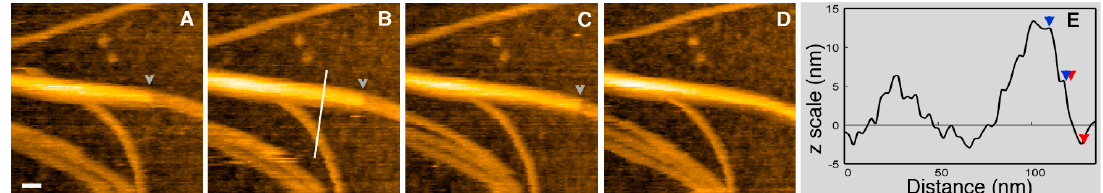
Figure 1. ( A – D ) Time lapse of the protofibril elongation stacked on top of a fibril. The grey arrowheads indicate the edge of the elongating protofibril on top of a fibril. ( E ) The profile (corresponding to the white line in ( B )) indicates that only two fibers are stacked on top of each other. Images were collected successively separated by 1 s. Scale bar: 30 nm. Adapted from Ref. [99].